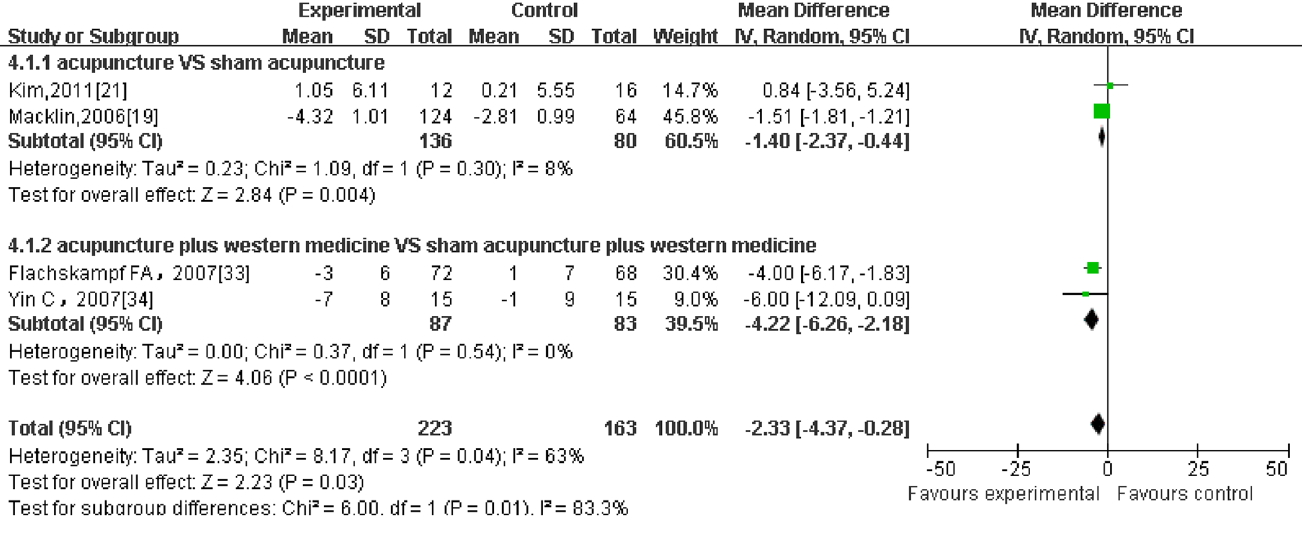
Fig 5. The forest plot of outcome measure ‘ DBP change magnitude.